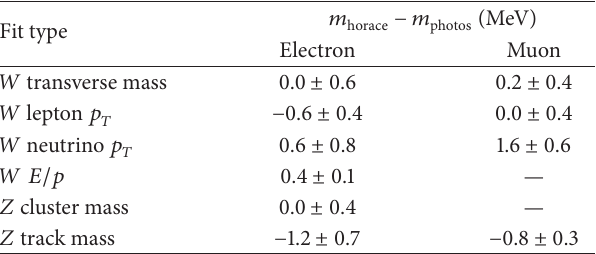
Table 2: Difference between horace and photos pseudodata in fitted masses. Templates were made using horace. The shift in the dimensionless 𝐸/𝑝 value has been multiplied by 80GeV to convert to the equivalent shift in the fitted 𝑊 boson mass. The statistical errorsareshown.Thetemplatesandpseudodatause10billionevents at the generator level as the input to the detector